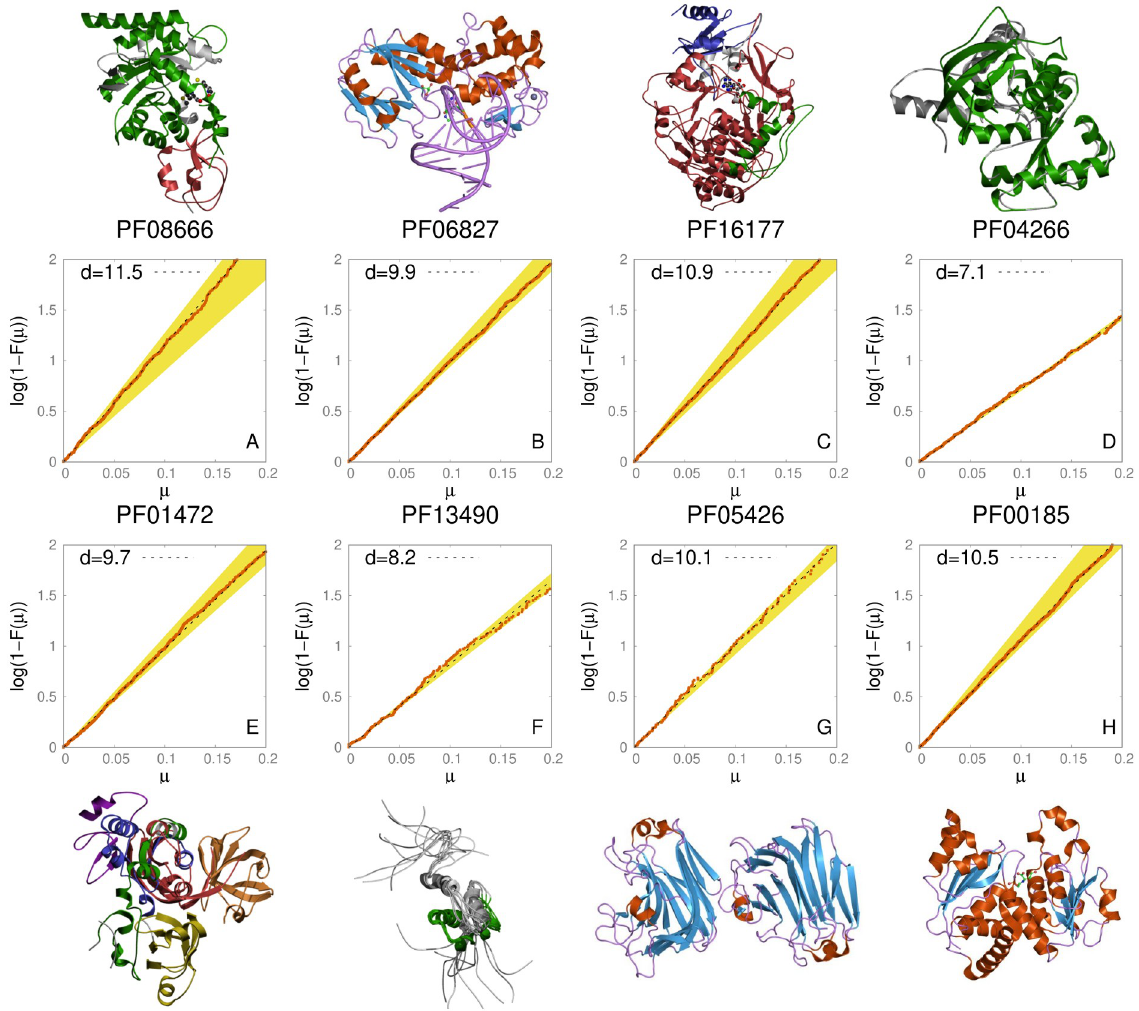
Fig 2. S set and estimated ID for a selection of Pfam A families. Panel A: we display the S set and the intrinsic dimension for PFAM domains PF08666 and the relative pdb structure. Panel B: same as A for PFAM domain PF06827. Panel C: same as A for PFAM domain PF16177. Panel D: same as A for PFAM domain PF04266. Panel E: same as A for PFAM domain PF01472. Panel F: same as A for PFAM domain PF13490. Panel G: same as A for PFAM domain PF05426. Panel H: same as A for PFAM domain PF00185. The pdb structures show that the results do not seem to depend on the structural characteristics that, among the chosen families, turn out to be highly heterogeneous.